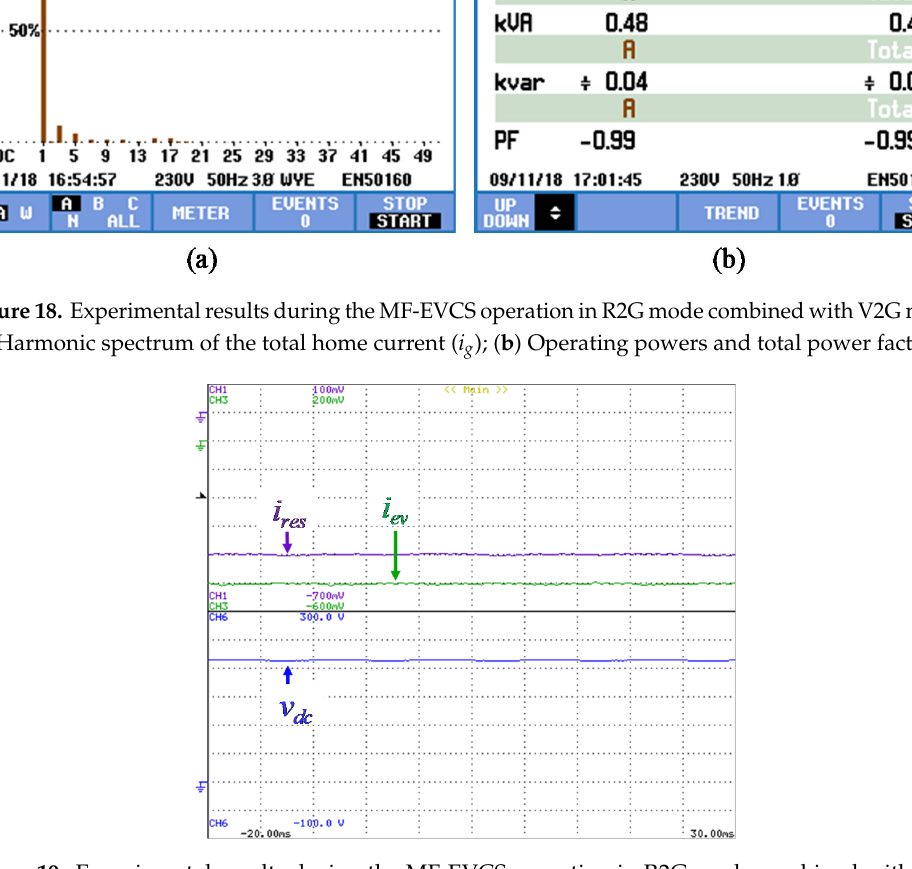
Figure 19. Experimental results during the MF-EVCS operation in R2G mode combined with V2G mode: Current in the EV battery ( i ev : 0.5 A/div); Current in the RES interface ( i res : 2 A/div); Dc-link voltage ( v dc : 50 V/div).